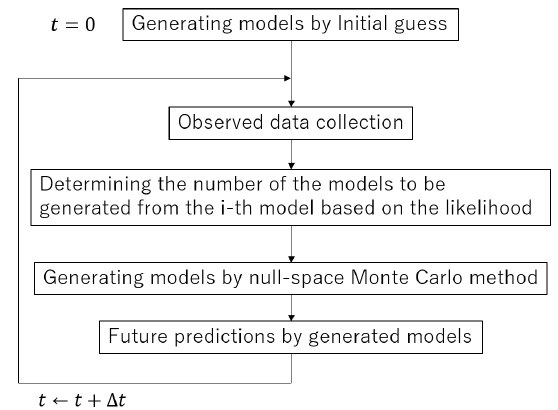
Figure 1. Flowchart of the proposed